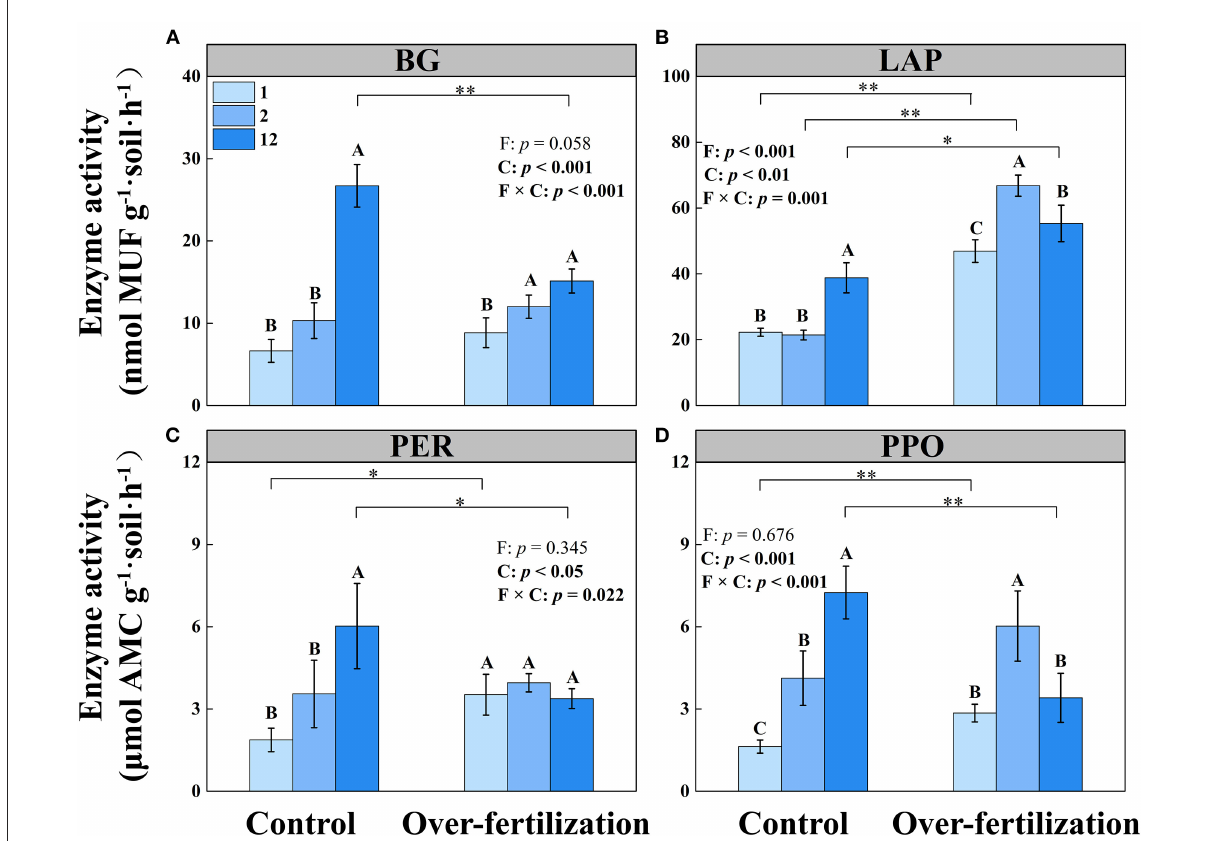
FIGURE2 Effects of fertilization on soil enzyme activity under tomato cropping. (A) The activity of β -1,4-glucosidase (BG). (B) The activity of leucine aminopeptidase (LAP). (C) The activity of peroxidase (PER). (D) The activity of polyphenol oxidase (PPO). Values are means ± SD ( n = 3). * and ** indicate significant differences between fertilization under the same cropping duration at p < 0.05 and p < 0.01, respectively. Different letters (A, B, and C) above the bars indicate significant ( p < 0.05) differences between cropping durations under the same fertilization treatments. F, fertilization; C, cropping